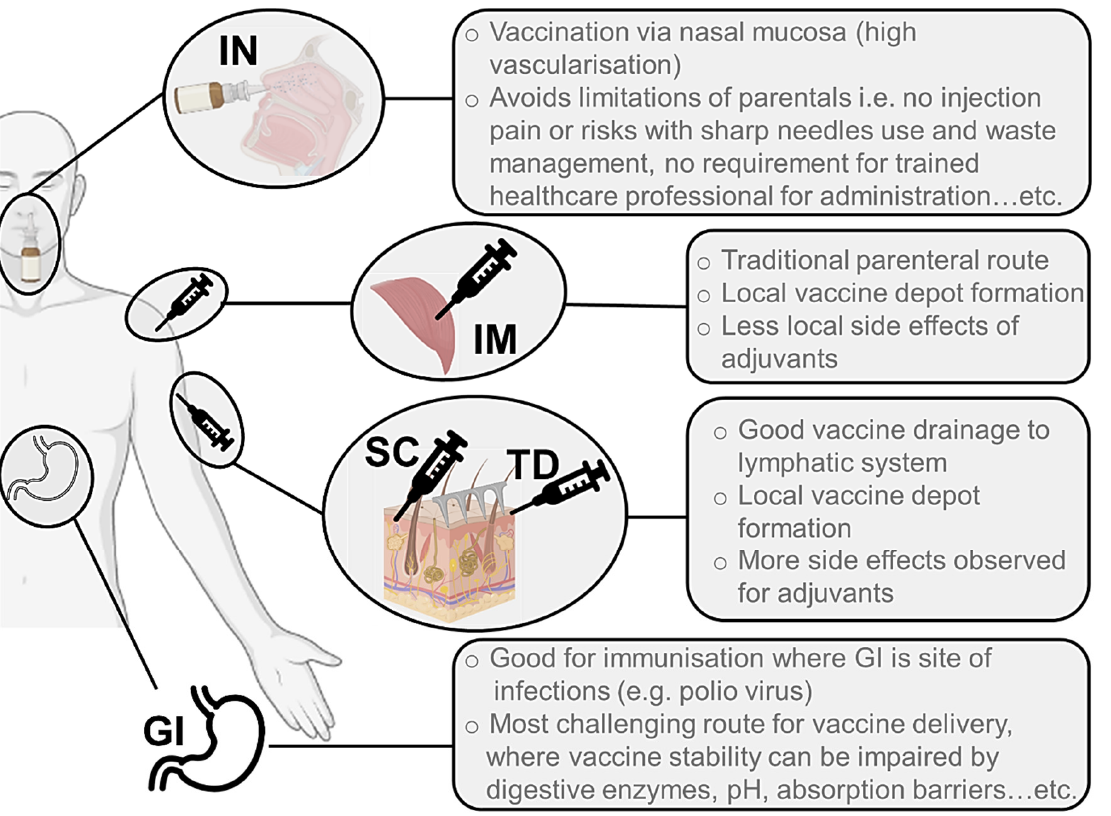
Figure 1. Illustration of the main routes of administration used for delivery of vaccines against viruses. These are IN (intranasal), IM (intramuscular), SC (subcutaneous), TD (transdermal) and oral (GI, gastrointestinal).